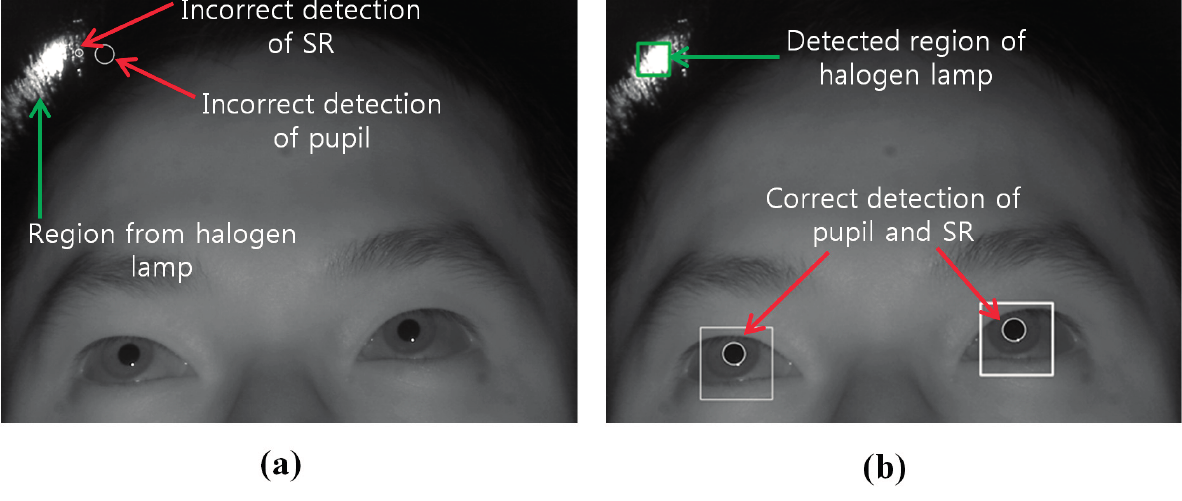
Figure 23. Result image of pupil and SR detection ( a ) not using our method; ( b ) using our